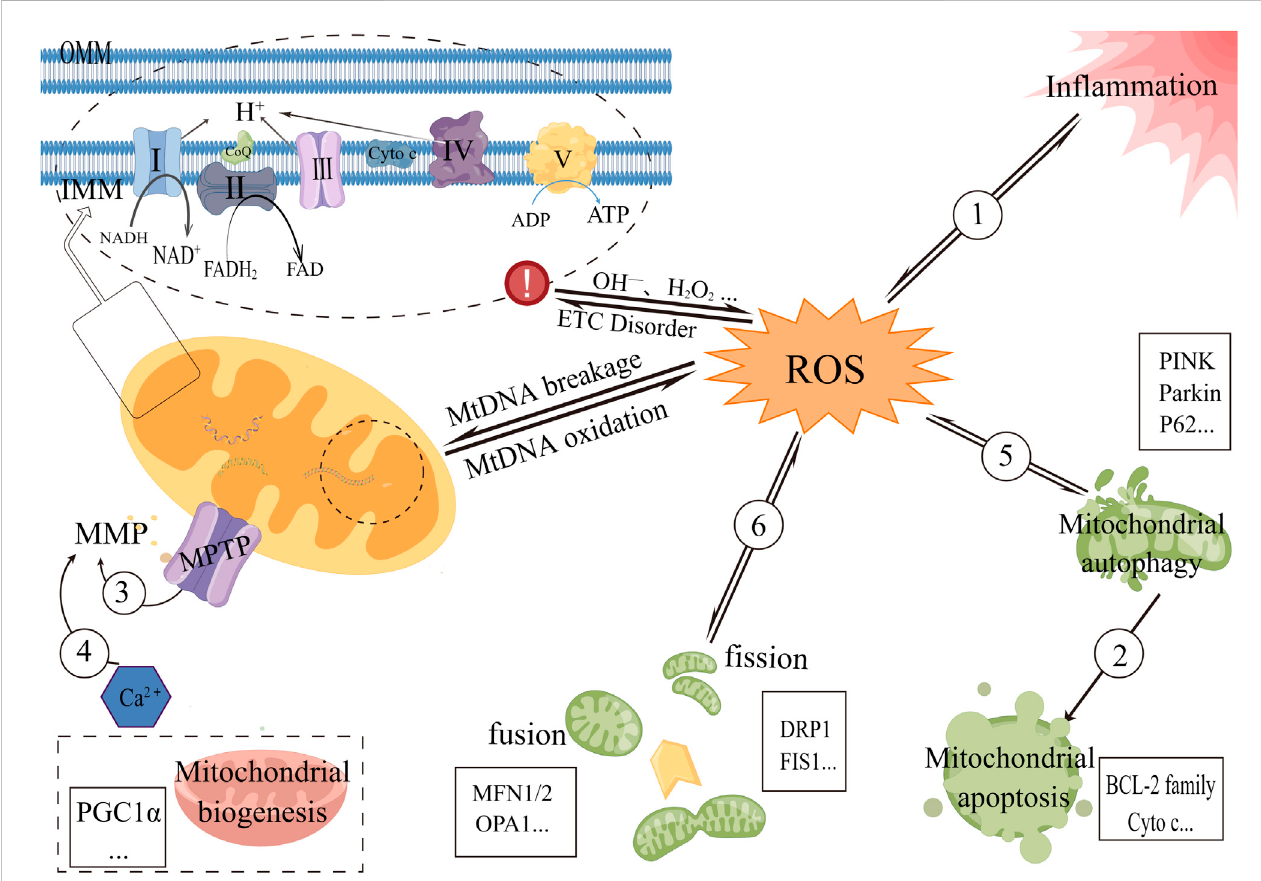
FIGURE 1 Diagram of some mechanisms of mitochondrial dysfunction in metabolic-associated kidney diseases 1) Oxidized mtDNA fragments can enter the cytoplasm via MPTP and then bind to NLRP3 and cyclic guanosine monophosphate-adenosine monophosphatesynthase (cGAS), whichcan also activate the NLRP3 in fl ammasome. ROS can also induce exacerbation of in fl ammation. 2) Autophagy of the mitochondrial pathway disrupts the mitochondrial bilayer structure and activates apoptosis-related proteins, causing apoptosis in the mitochondrial pathway. 3) Increased MPTP opening results in the release of negatively charged proteins into the mitochondrial matrix, which affects ion concentrations on both sides of the mitochondrial inner membrane and, ultimately, causes MMP levels to drop. 4) Ca2 + triggers a common mitochondrial membrane permeability transition (MPT), resulting in abnormal MPTP opening, mitochondrial swelling, and decreased membrane potential. 5) Mitochondrial autophagy maintains the integrity of mitochondrial function and reduces ROS production, and in turn, excess ROS can selectively degrade oxidatively damaged mitochondria by preferentially activating mitochondrial autophagy, thereby reducing its damage to cells. 6) Excessive ROS-induced oxidative stress decreases mitochondrial fusion and increases fi ssion. Mitochondrial fi ssion leads to changes in the mitochondrial membrane that fragment the mitochondria and also lead to an increase in